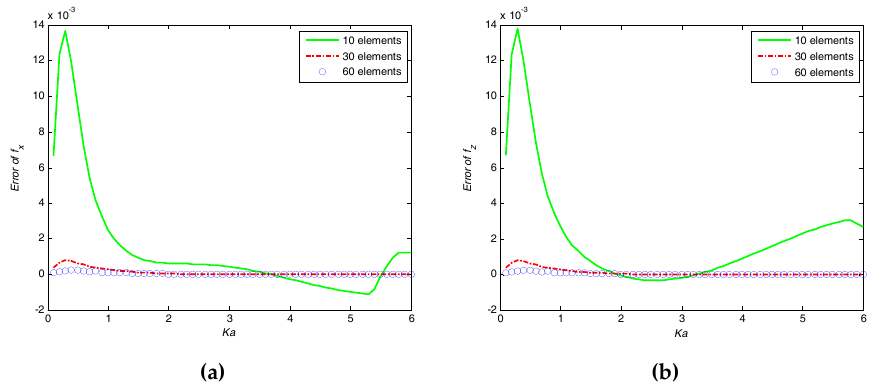
Figure 11. Convergence test of the present method to the exact solution [21] with respect to the number of elements: ( a ) sway exciting force; ( b ) heave exciting force.